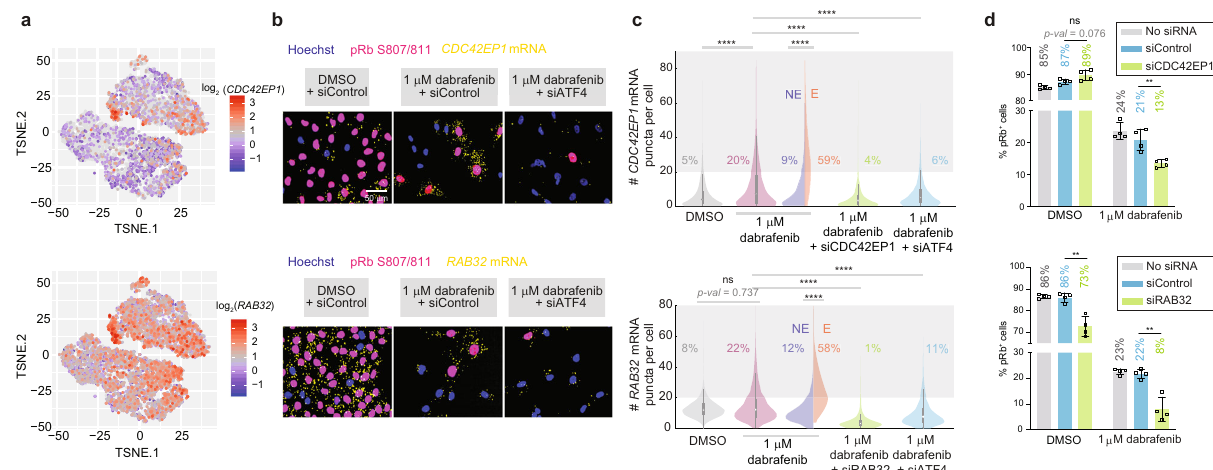
Fig. 5 Individual ATF4 target genes are involved in escape from dabrafenib-induced quiescence. a Visualization of single-cell CDC42EP1 and RAB32 mRNA expression levels on the combined t-SNE plot showing increased expression in the peninsula containing escapees. b Representative RNA-FISH images for CDC42EP1 or RAB32 with phospho-Rb (S807/811) and Hoechst staining. c Violin plot showing the number of mRNA puncta for CDC42EP1 or RAB32 in A375 cells treated under the indicated conditions for 72 h. The percentage of cells with >20 mRNA puncta is indicated on the plot. Each population value is pooled from two replicate wells. d The percentage of pRb + cells in the indicated conditions. A375 cells were treated for 72 h. Error bars: mean ± std of four biological replicates, representative of two experimental repeats. Source data are provided as a Source Data fi